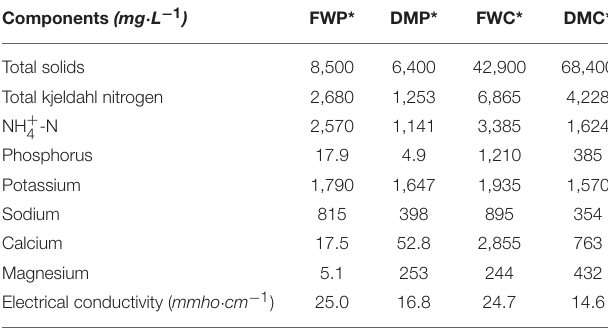
TABLE 2 | Nutrient and salt concentrations of the ultrafiltered and concentrated digestate biofertilizer products. Components (mg · L − 1 )